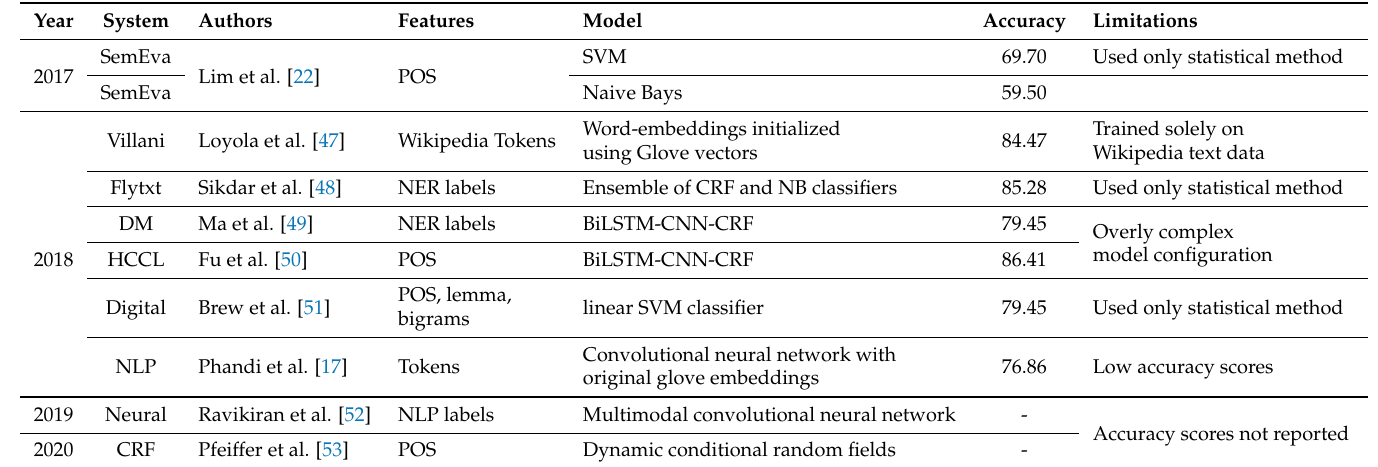
Table 1. Comparison with the present state-of-the-art